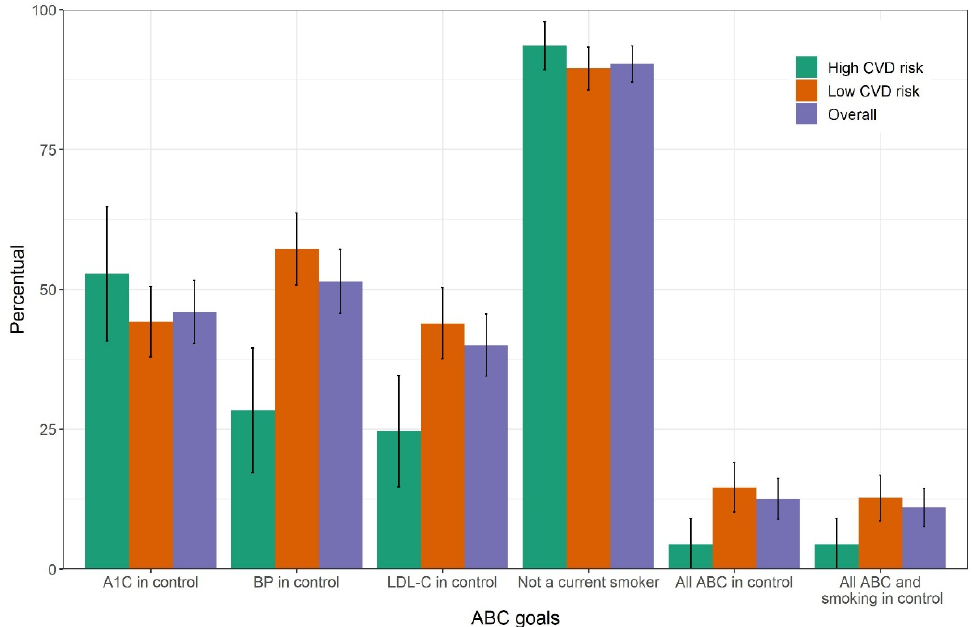
Figure 2. Percent attainment with 95% confidence interval for each of the three ABC goals, for the non-smoking goal and for combinations of goals among individuals with self-reported diabetes in the laboratory subsample of the Brazilian National Health Survey, 2014–2015. ABC, A1C (A), blood pressure (B) and cholesterol (C). CVD, cardiovascular disease.